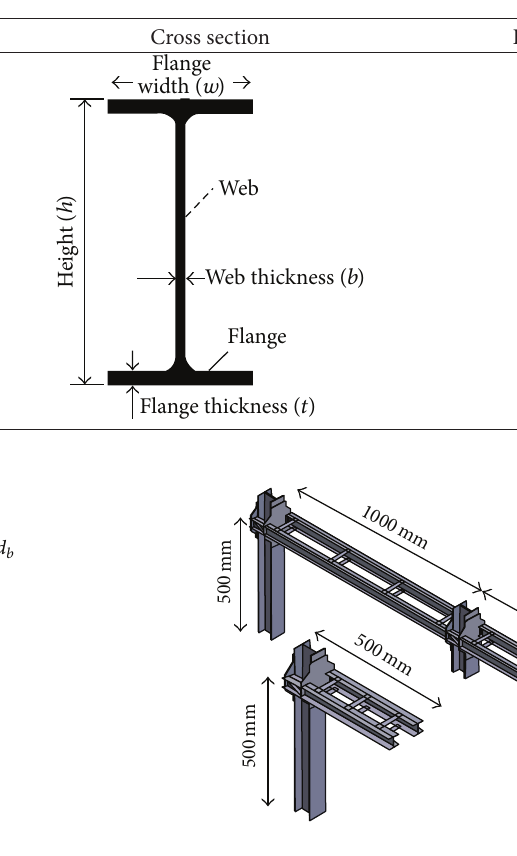
Table 1: Beam and column properties used in the saddlebag connection.